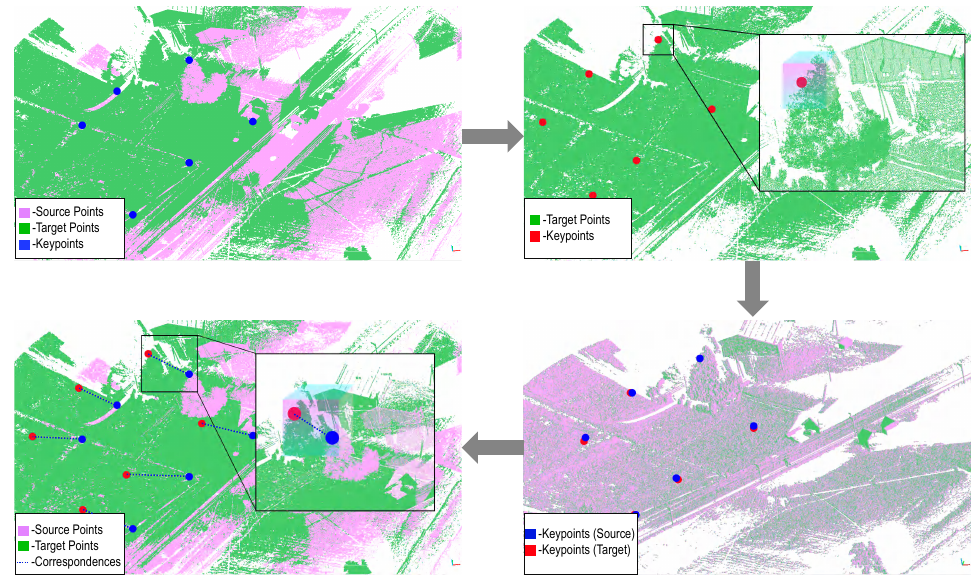
Figure 4. The whole process of 3D registration. The first step is to search and determine the respective feature points from the source and target point clouds based on their initial positions. According to the local features, the matching relationship between the feature points is further determined. Lastly, the feature points with the same name are transformed to the same position, and the point cloud is converted to the same coordinate system. ( : Source